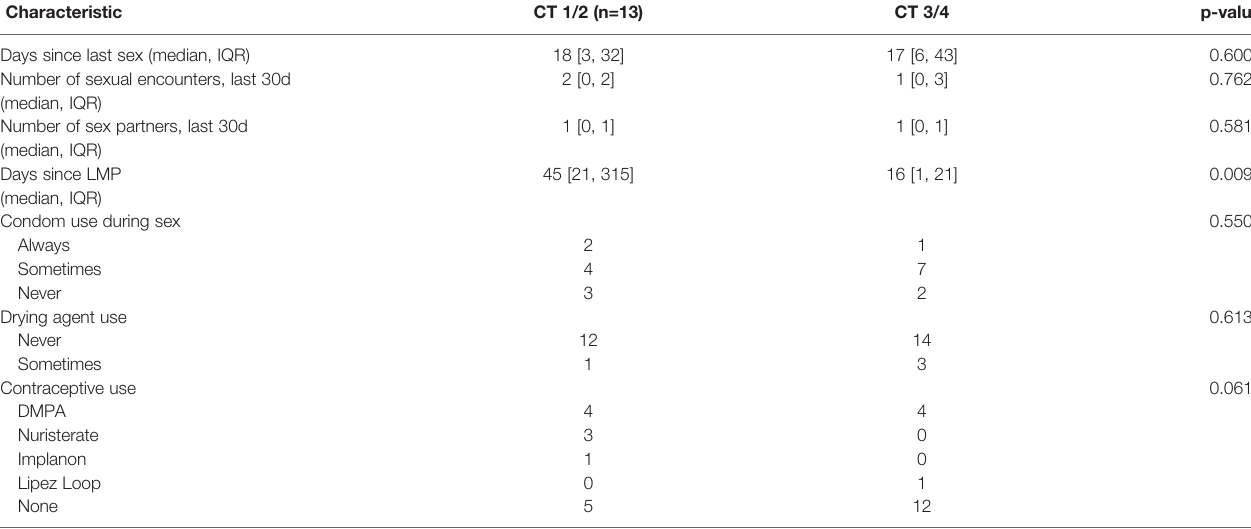
TABLE 1 | Demographics of FRESH participants included in